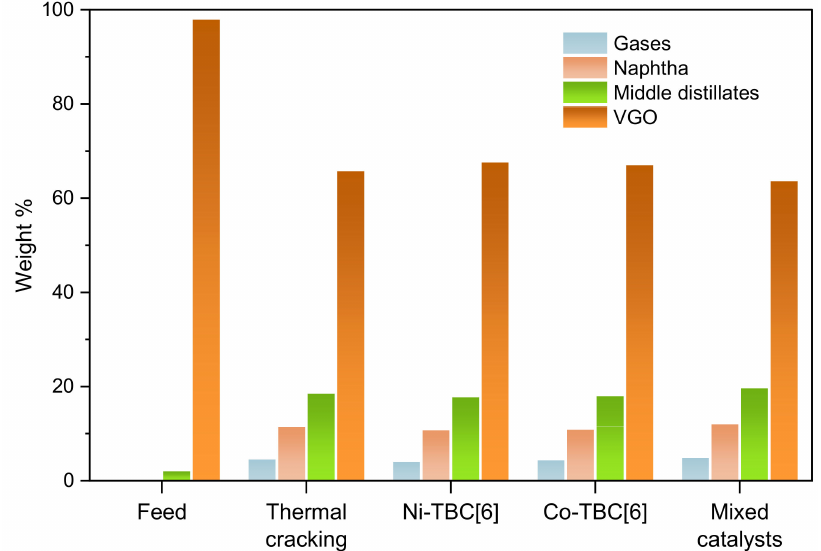
Figure 4. Product yield distribution of VGO hydrocracking at 420 ◦ C under an H 2 pressure of 8.5 MPa for a reaction time of 1 h for dispersed metal catalysts. The dispersed catalysts’ metal concentration for Ni-TBC[6], Co-TBC[6], and mixed catalysts were 500 ppm for each case. Coke yield for all cases was